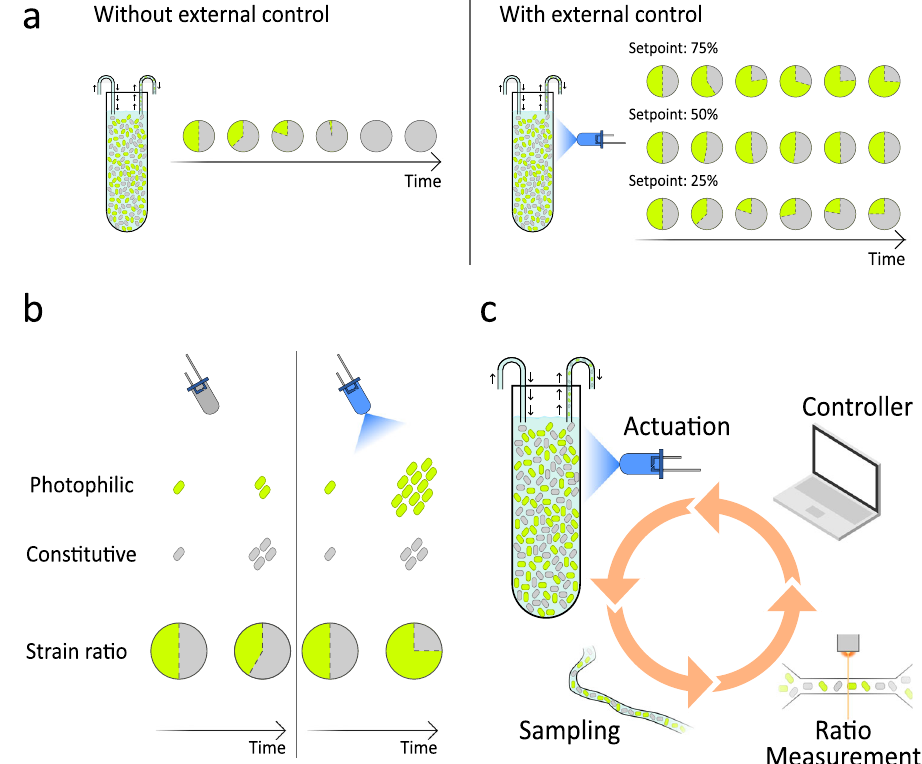
Fig. 1 | Compositional control of a bacterial co-culture via optogenetic feed- back.a Becauseofthecompetitiveexclusionprinciple,twonon-interactingstrains thatcompeteforcommonspaceandresourcescannotstablycoexistinaco-culture (left). In this study, we show that the precise composition of such a co-culture can be modulated and stabilized at arbitrary strain ratios using external optogenetic feedback (right). b Our co-cultures contain a constitutive strain, which grows at a fi xed rate independent of light, and a photophilic strain, whose growth is stimu- latedby blue-light.The fate of the co-culturecan be controlled throughthe choice